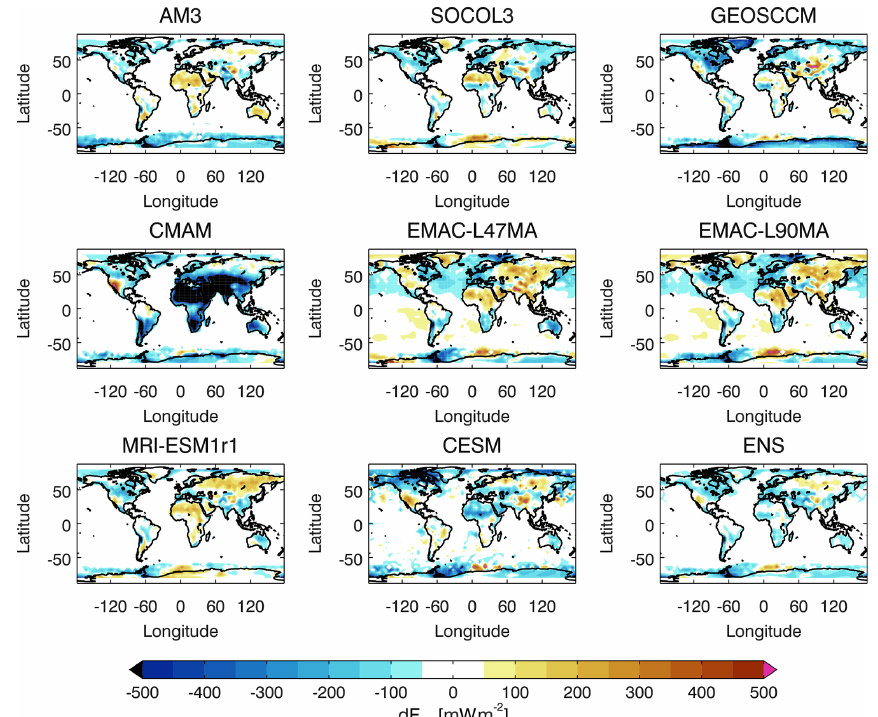
Figure 8. Global distribution of the T s radiative